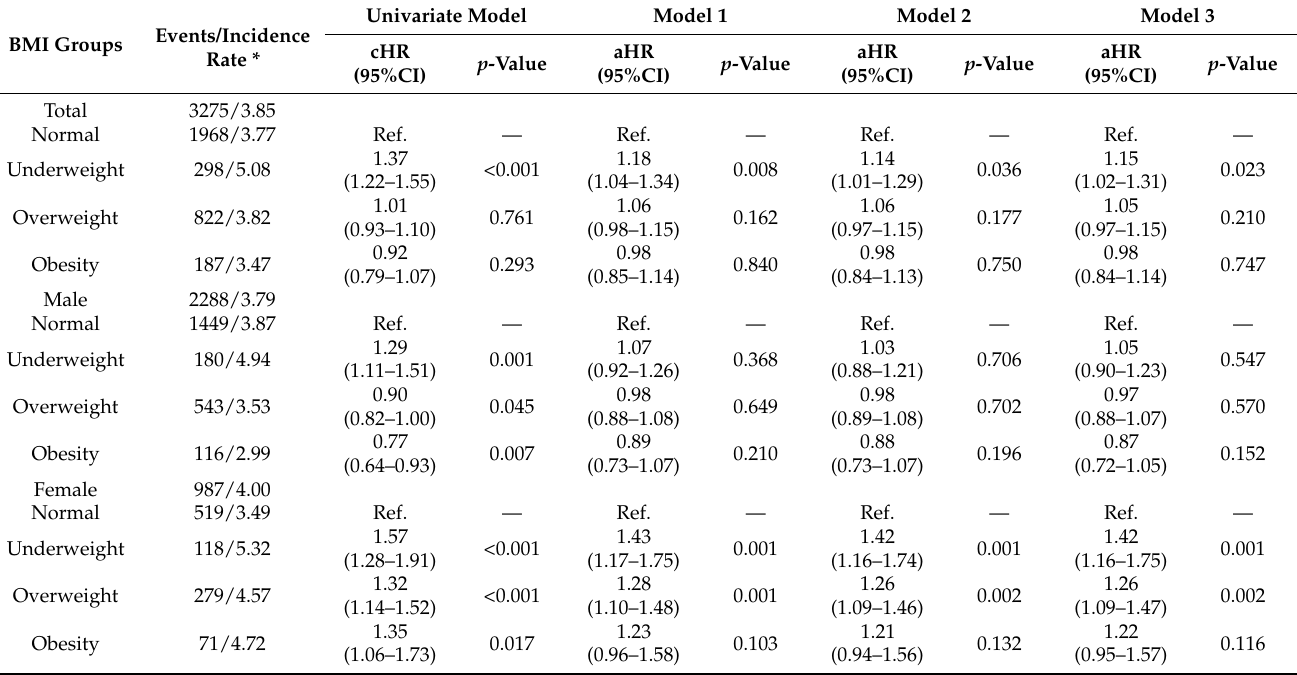
Table 2. Univariate and multivariate Cox proportional hazard analyses for association of BMI with risk of CHE stratified by